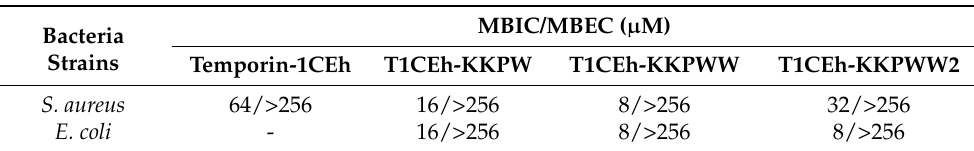
Table 4. MBIC and MBEC of Temporin-1CEh, T1CEh-KKPW, T1CEh-KKPWW and T1CEh-KKPWW2 against S. aureus (ATCC CRM 6538) and E. coli (ATCC 8739). The peptide concentrations which inhibited more than 90% of biofilm formation or eradicated more than 90% of mature biofilm, are defined as the MBIC and MBEC, respectively.